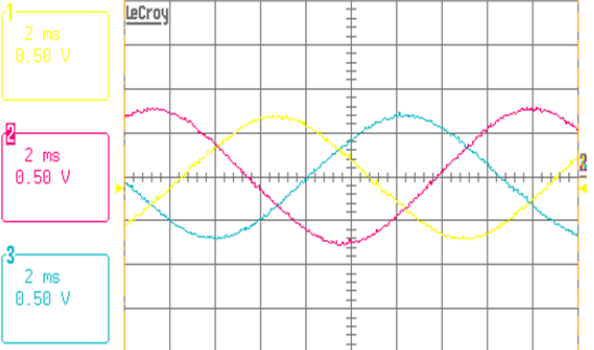
Figure 9. Experimental results of the back-EMF measurement (720 rpm).